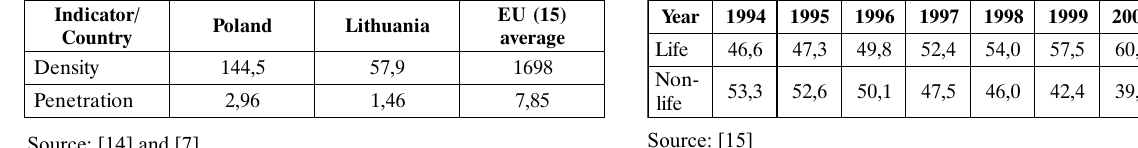
Table 7. Gross premium in EU-15 countries, in years 1994–2001, in mln USD, previous year = 100 raeY